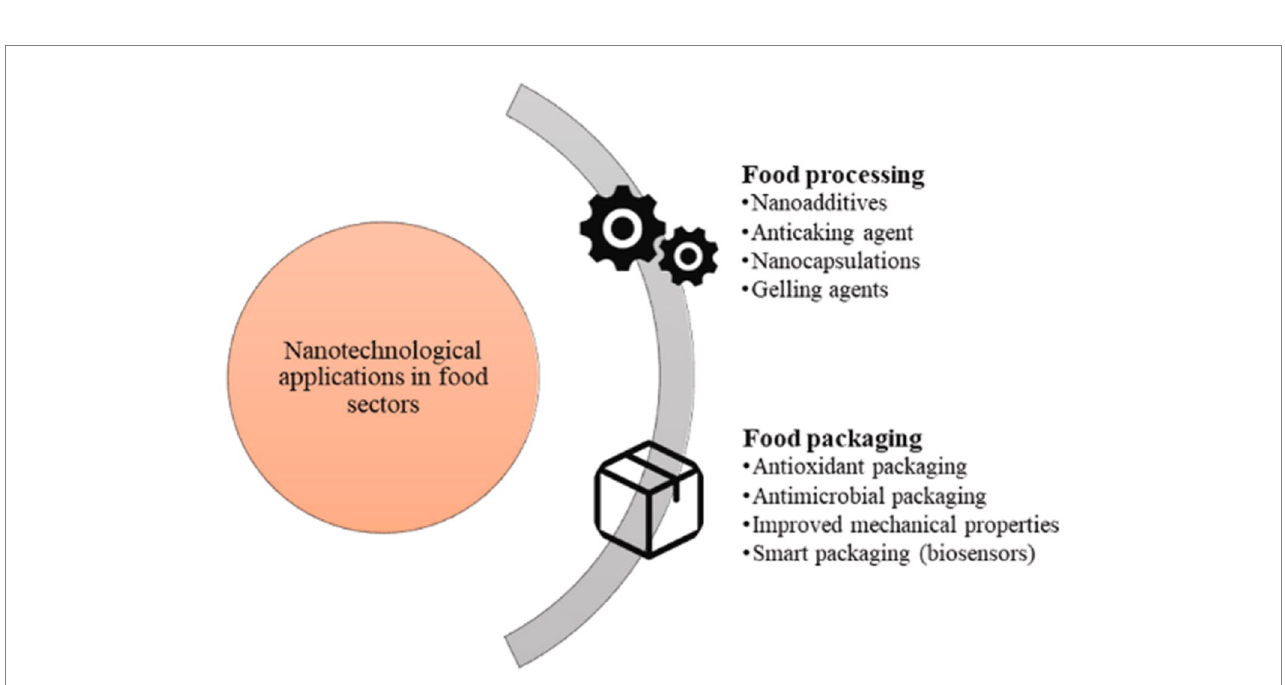
FIGURE 9 Nanotechnology in Food